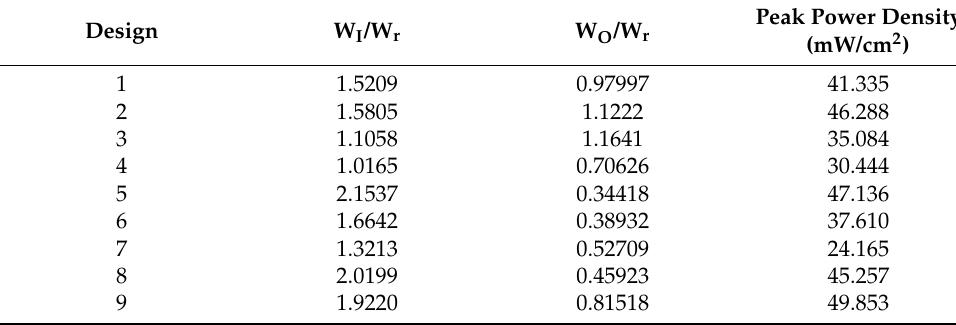
Table 4. Design variables and objective function values at sample